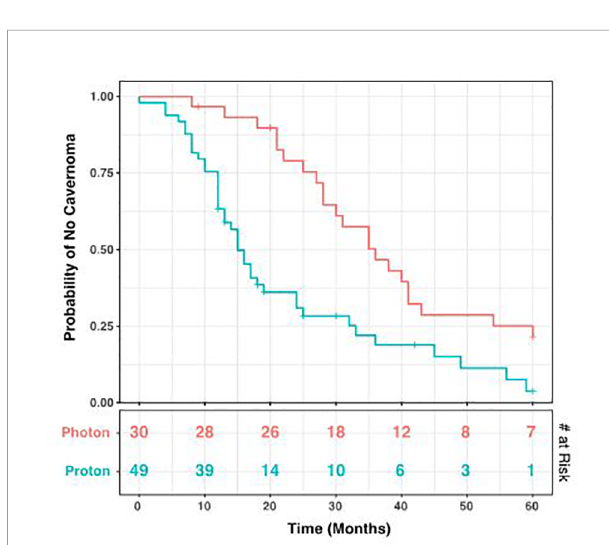
FIGURE 4 | Kaplan-Meier Curve for Development of Cavernomas. Over a 60-month period after radiation, cavernoma development occurred earlier in patients receiving proton radiation compared to those receiving photons (log rank p= 5.95 x 10 -4 ). The number at risk at each time point is shown in the bottom table. Tick marks indicate patients lost to